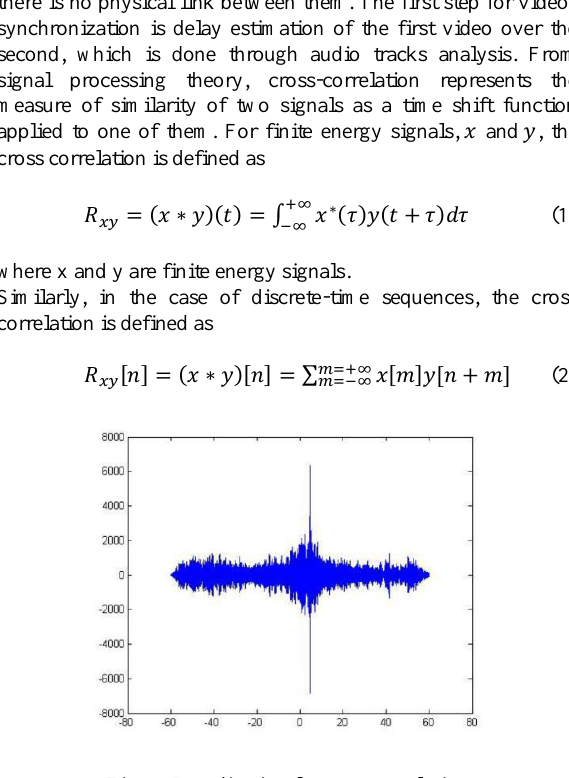
Figure 5. audio signals